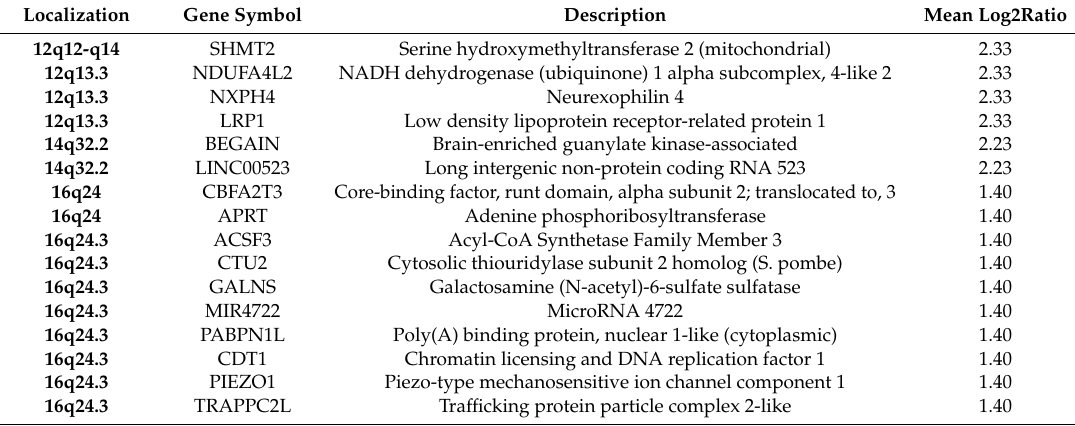
Table 1. Recurrent Gains Shared by at Least three of eight Tumors. Aberrant SCNAs Were Defined as log2 (ratio) < − 1 or >